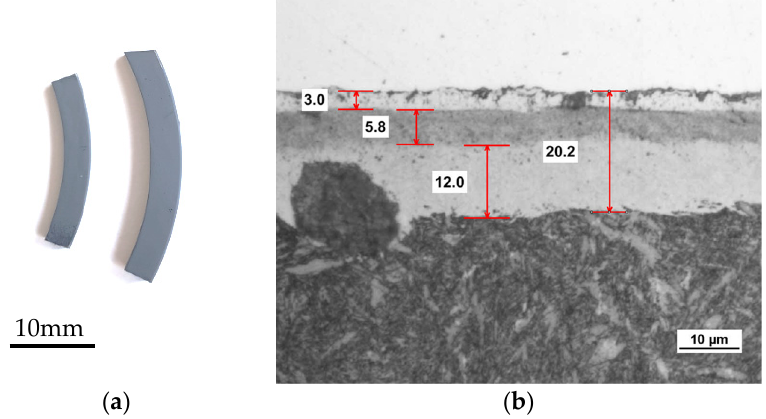
Figure 1. ( a ) External appearance of samples after spray coating and preliminary annealing. Sintering parameters: temperature: 300 °C, time: 2 h ramp 5 °C/min withstand for 1 h in N atmosphere; ( b ) Exemplary cross section of final microstructure of hybrid layer – option A.